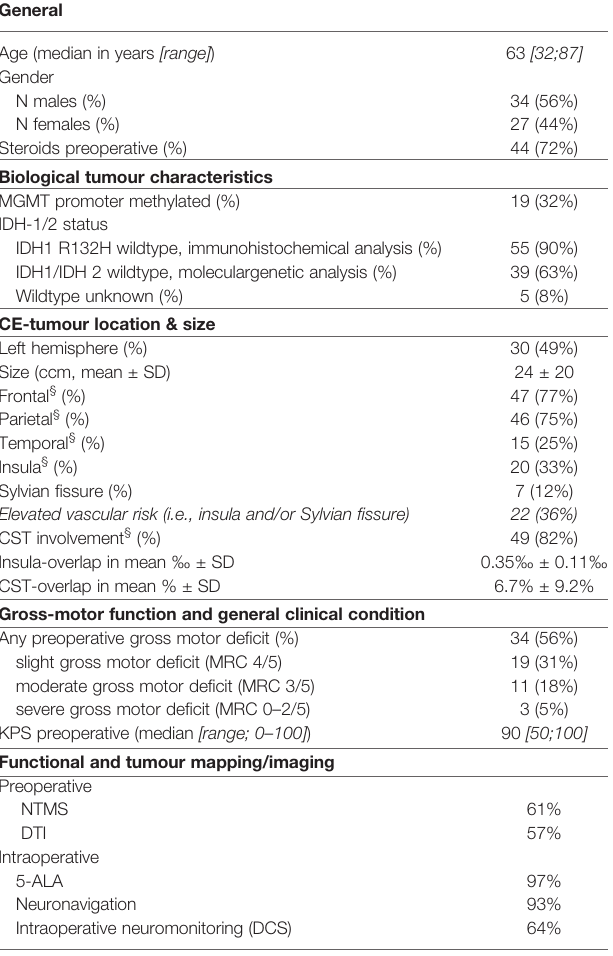
TABLE 1 | Patient characteristics.